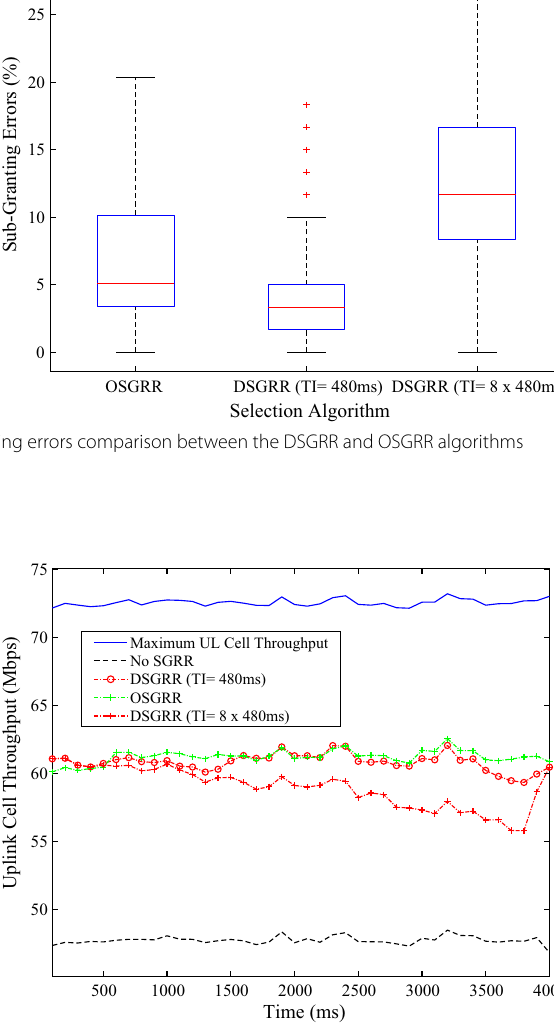
Fig. 17 Performance of different approaches in terms of cell throughput. The impact of measurement and position information transmission interval for the dedicated algorithm is